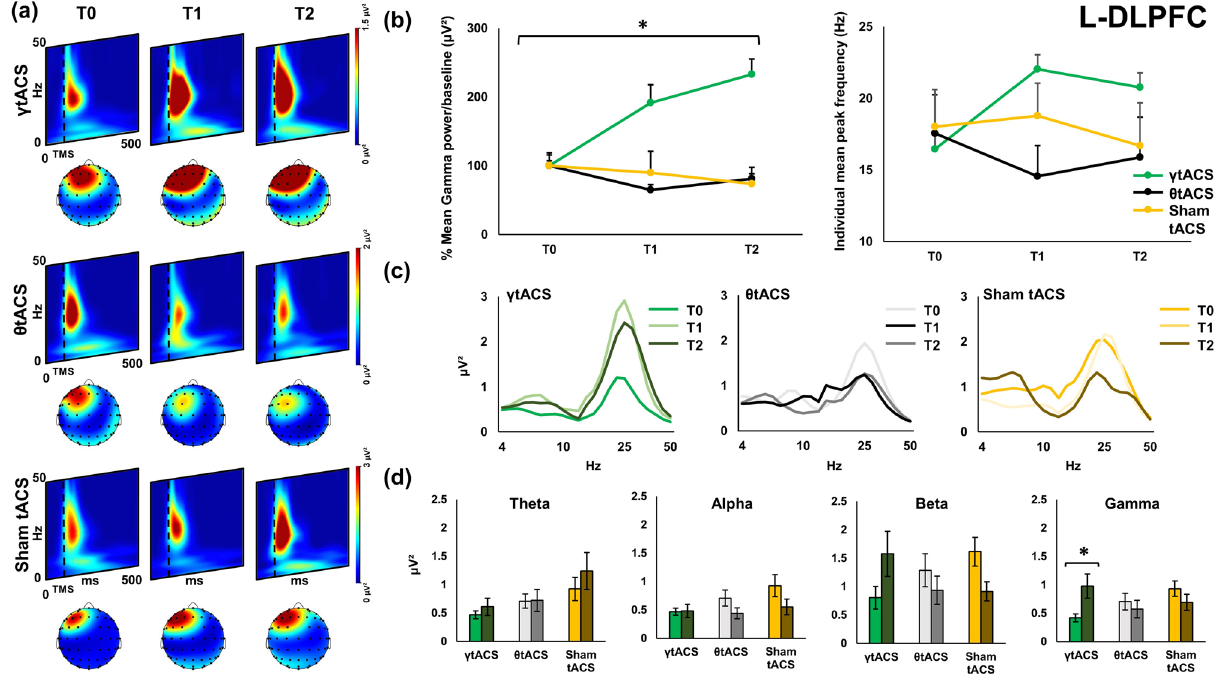
Figure 1. Local transcranial magnetic stimulation (TMS)-evoked cortical oscillations of the left dorsolateral prefrontal cortex (l-DLPFC). Panel ( a ) represents time–frequency oscillations for the three stimulation conditions and time points. Topographical maps depict the spatial cortical activation during TMS-EEG (50 ms after TMS pulse, 25 Hz). All maps and time–frequency representations were generated by BrainVision Analyzer (v 2.2; https:// www. brain produ cts. com/ solut ions/ analy zer/). Panel ( b ) shows the power and shifting analysis performed on cortical oscillations. The panel represents on the left the % changes of the Gamma frequency in terms of power with respect to baseline. Moreover, the right side of the panel shows the shifting of the individual frequency in terms of Hz with respect to the three time points. Furthermore, panel ( c ) shows power expression of the whole frequency spectrum calculated for the cortical oscillations analysis. Lastly, panel ( d ) shows the four frequency bands considered for the analysis (Theta, Alpha, Beta, Gamma) and their change in power (μV 2 ) during time (T0, T1, T2) for every stimulation